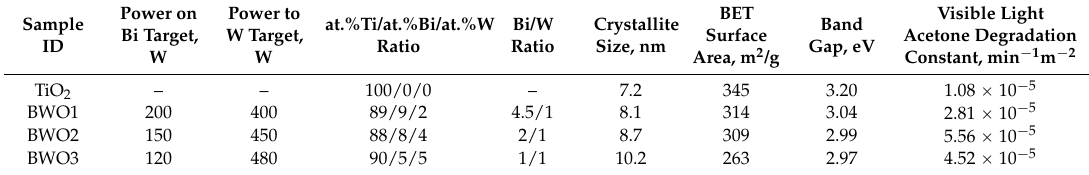
Table 1. Overview of the properties of bismuth tungstate-coated and uncoated titania powders.